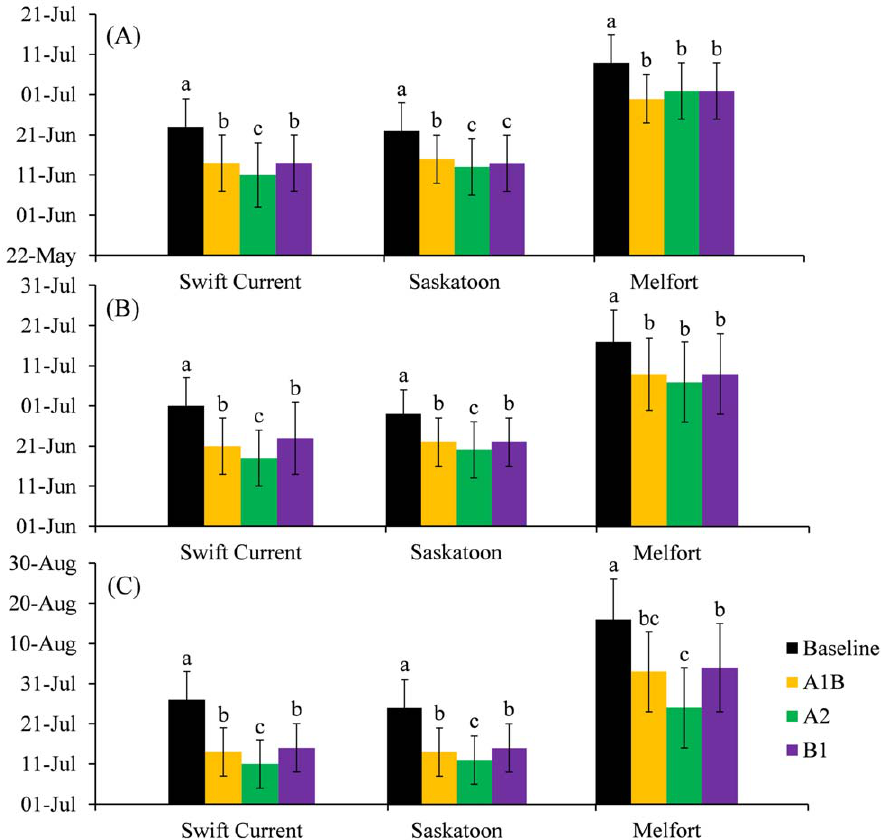
Figure 5. Effects of climate change on phasic development of wheat in (A) anthesis, (B) early dough and (C) maturity. Within each site, values followed by the same letter are not significantly different at the 0.05 level of probability. Vertical bar indicate standard deviation (days).